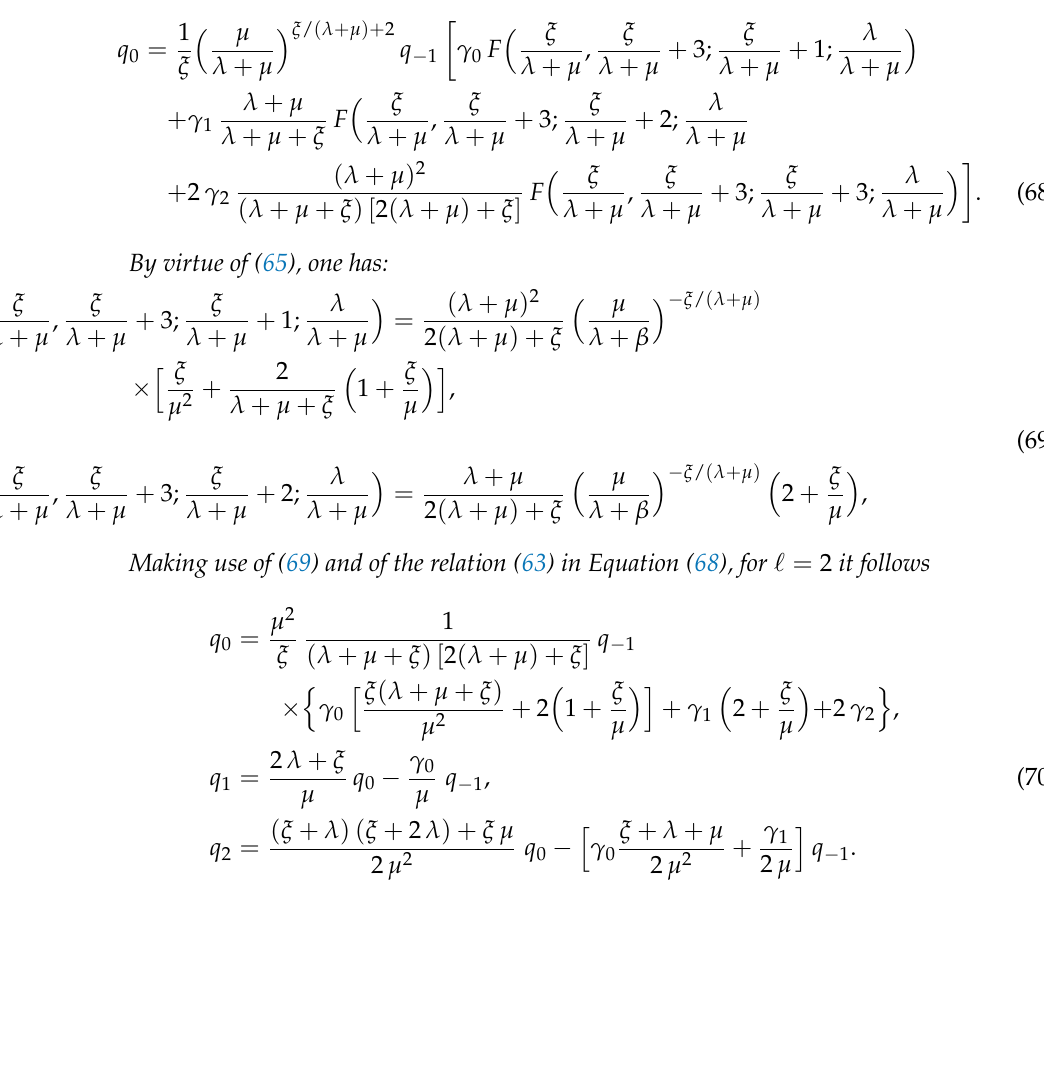
Figure 8. The state diagram of the Markov chain N ( t ) with (cid:96) = 2. In this case, there are three operating states 0 , 1 and 2 , with the intensity functions of failure ξ ( t ) = ξ ϕ ( t ) , of repair (cid:36) ( t ) = (cid:36) ϕ ( t ) and of restores γ i ( t ) = γ i ϕ ( t ) for i = 0, 1, 2 ; the birth- death intensity functions are λ n ( t ) = ( 2 − n ) λ ϕ ( t ) for n = 0, 1 and µ n ( t ) = n µ ϕ ( t ) for n = 1, 2 . By setting (cid:96) = 2 in the first equation in of (54) one